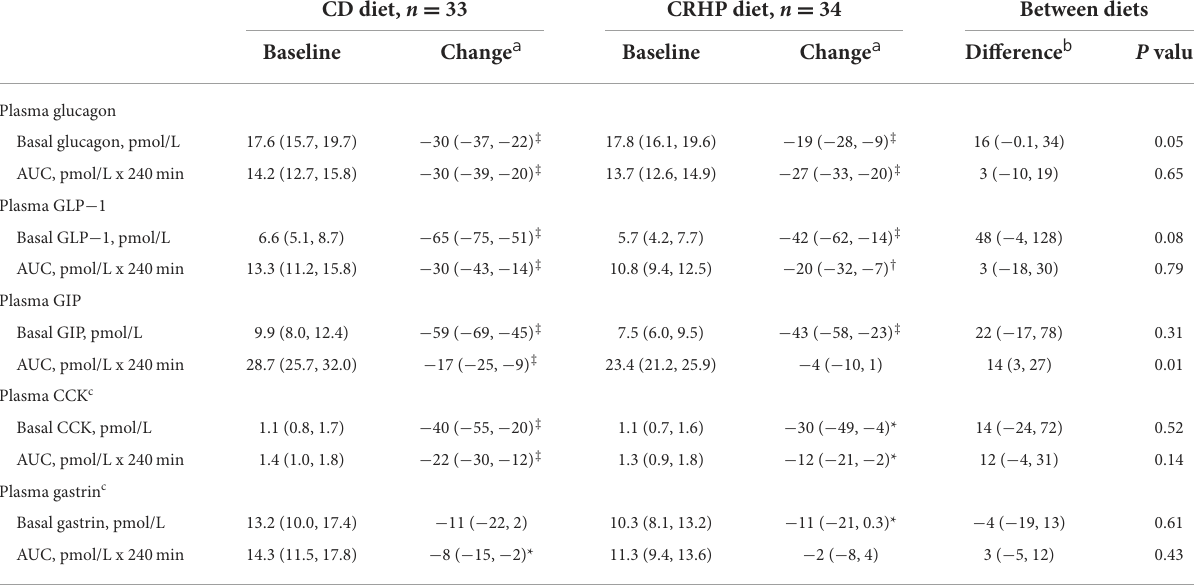
TABLE 3 Basal concentrations and responses to an oral glucose tolerance test of glucagon, GLP-1, GIP, CCK, and gastrin at baseline and after matched ∼ 6% weight loss by a CD or a CRHP diet in individuals with T2D and overweight or obesity. CD diet, n = 33 CRHP diet, n = 34 Between diets Baseline Change a Baseline Change a Difference b P value Plasma glucagon Basal glucagon,